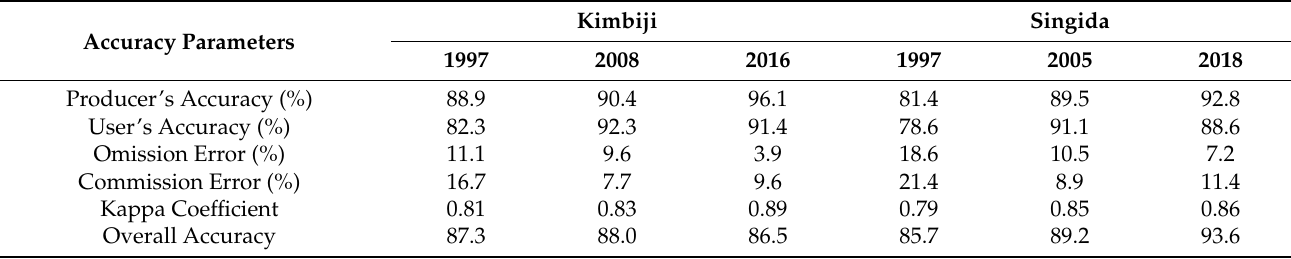
Figure 4. Land cover maps for the Kimbiji and Singida aquifers. ( A ) LULC for 1997 in Singida, ( B ) LULC for 2005 in Singida, ( C ) LULC for 2018 in Sin-gida, ( D ) LULC for 1997 in Kimbiji, ( E ) LULC for 2008 in Kimbiji, ( F ) LULC for 2016 in Kimbiji. Table 8. Accuracy Assessment parameters for land cover classification